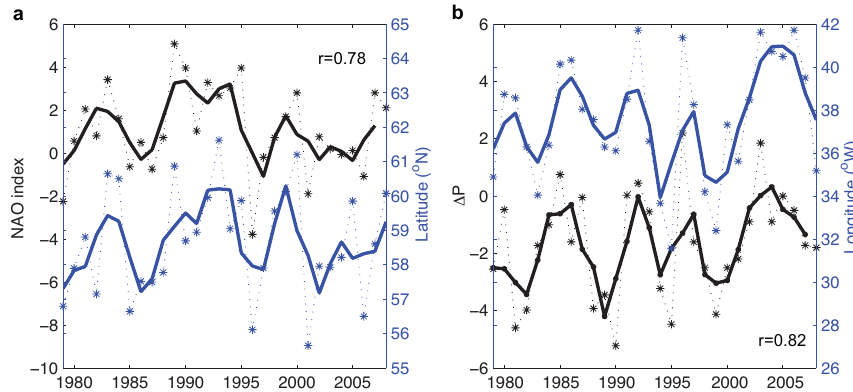
Fig. 10. (a) Plot showing the relationship between the mean latitude of the Icelandic Low (IL) during December–March and the extended (December–March) NAO winter index. (b) Same as (a) but showing the relationship between the longitude of the IL centre and 1 P . Solid lines show the 3-year running